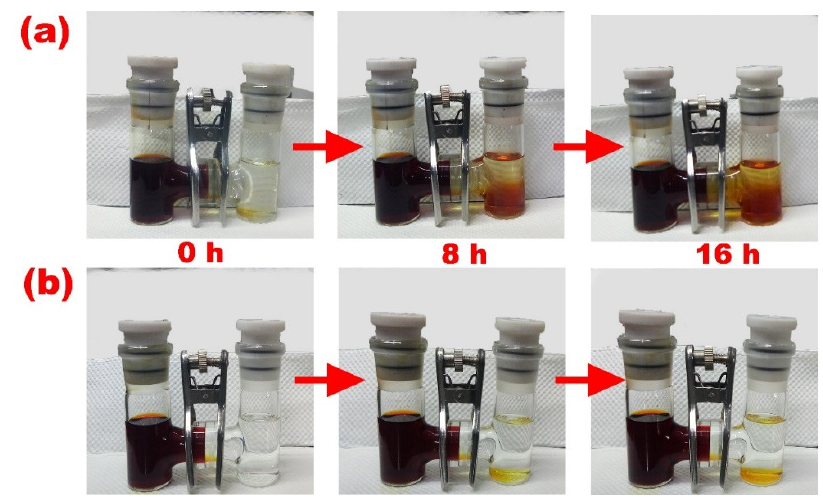
Figure 7. Photographs of H-type glass cells assembled with the ( a ) conventional separator and the ( b ) ZnO/NDG composite-coated separator.